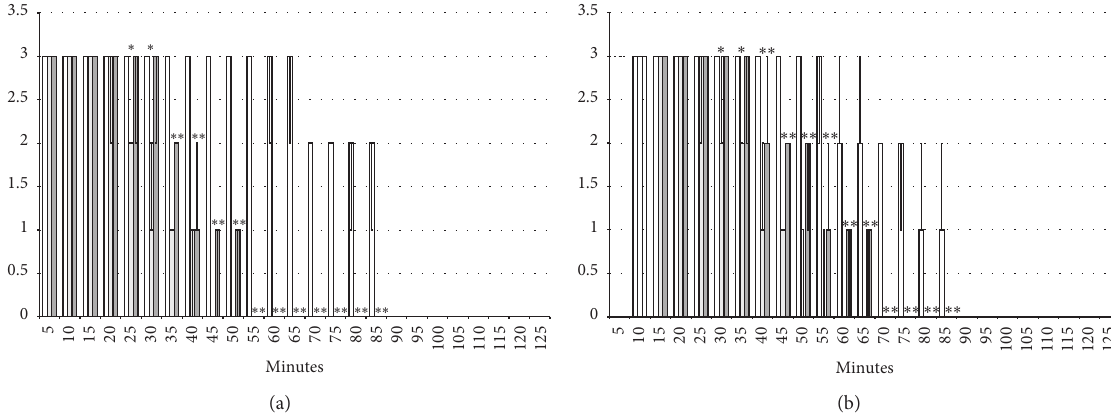
Figure 8: Spinal block (function failure and flaccid paralysis): intrathecal anesthesia produced a prolonged hind limbs function failure and long-lasting flaccid paralysis (white bars) which BPC 157 opposed. Prophylactic effect: BPC 157 medication (gray bars) (10 μ g/kg (light gray bars), 10 ng/kg (dark gray bars) intraperitoneally) given immediately after lidocaine (a) considerably counteracted lidocaine-induced course. Therapy effect: BPC 157 medication (gray bars) (10 μ g/kg (light gray bars), 10 μ g/kg (dark gray bars) intraperitoneally) given later, at 10 minutes after lidocaine (b), considerably counteracted lidocaine-induced course. With BPC 157 medication (10 μ g/kg, 10 μ g/kg intra- gastrically), an alike counteraction appears as well (data not specifically shown). Intrathecal anesthesia at the L4-L5 level rat spine, scored 0–3. Values are presented as min/med/max. ∗ P < 0 . 05 at least vs . control.